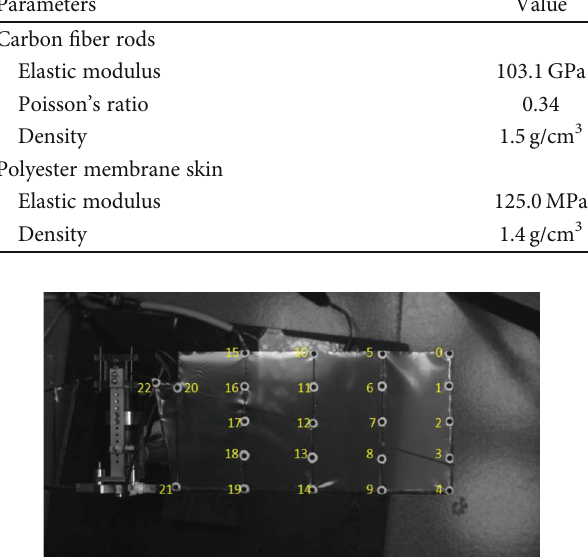
Figure 7: Flapping wing with speckles (same viewing angle to Figure